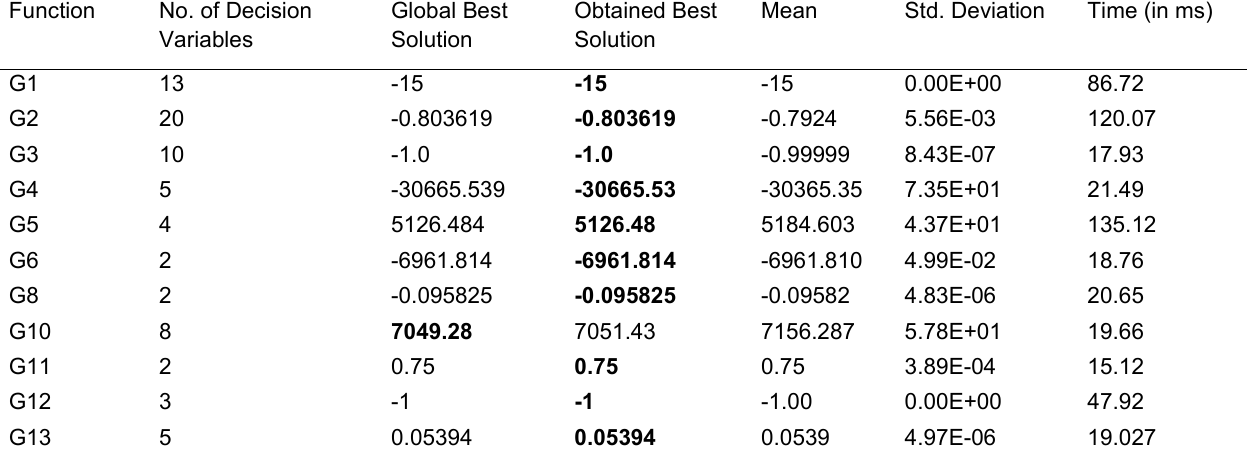
Table 2. Results obtained using GPGPU based multi-hive ABC algorithm for 11 benchmark functions Function